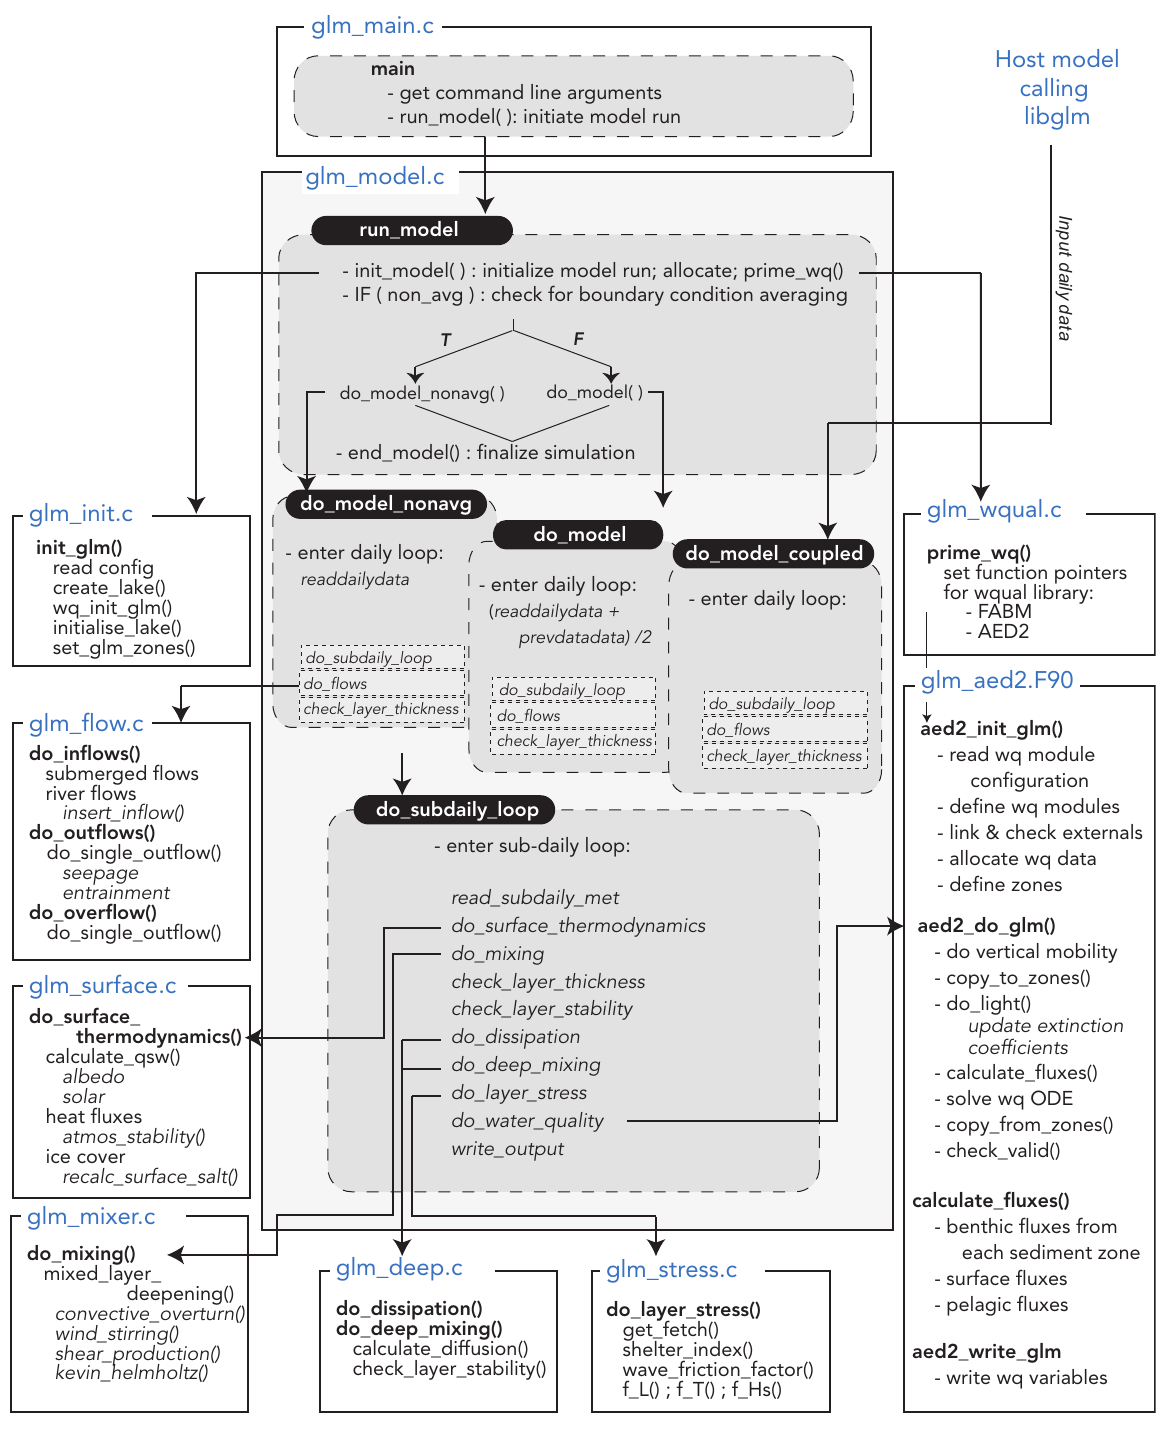
Figure 16. Overview of GLM code structure and programme flow. Modules are depicted as a box with the main routines and functions summarized. Three entry points to the main model routines are possible depending on the desired treatment of the inflow and outflow boundary condition data: do_model uses the flow boundary condition data over the present and previous day in order to get the midday value, do_model_nonavg uses that from the present day only, and do_model_coupled passes in the present day flows from the